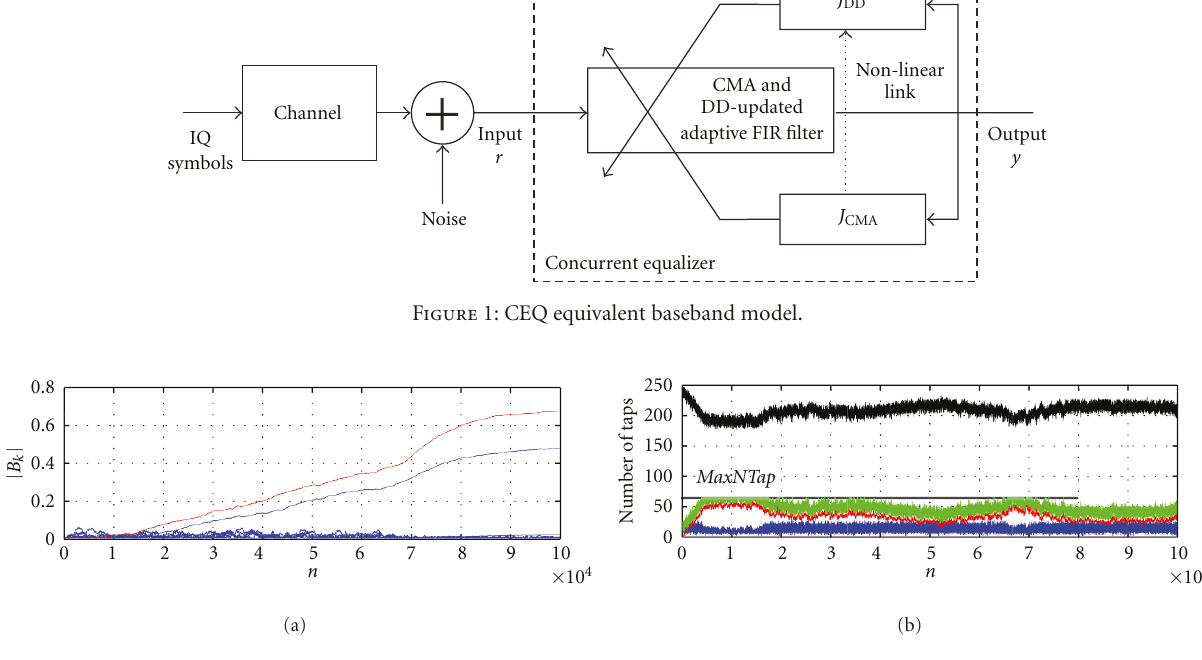
Figure 2: Curves for “Brazil A” profile Table 1 with 150Hz Doppler rotation, SNR = 30dB. σ = ( D min /γ ) 2 = 0 . 015 is the MSE convergence level, D min = | s k − s k − 1 | / 2, s k ∈ A . L = 256, FIR init @ B L/ 2 = 1 . 0, η CMA = 3 × 10 − 4 , and η DD = 10 η CMA . MaxNTap = 64, α max = 16, and ξ = 3 × 10 − 3 . (a) CEQ filter tap magnitude value | B k = 0,1, ... ,9, L = 256. (b) CEQTR tap rank distribution. k | in the range